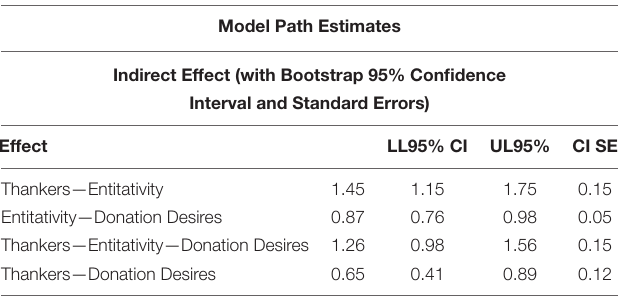
TABLE 1 | Study 1: mediation